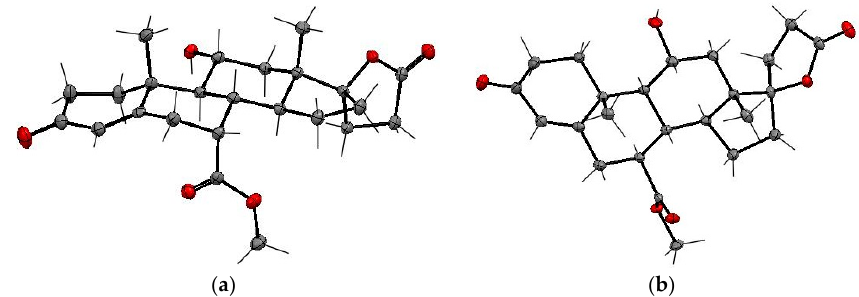
Figure 3. Molecular structure of the 11-hydroxyesters: ( a ) (7 α ,11 α ,17 α )- 12 and ( b ) (7 β ,11 α ,17 α )- 12a . Table 3. Summary of crystallographic data and structure refinement for the 11-hydroxyesters (7 α ,11 α ,17 α )- 12 and (7 β ,11 α ,17 α )- 12a .